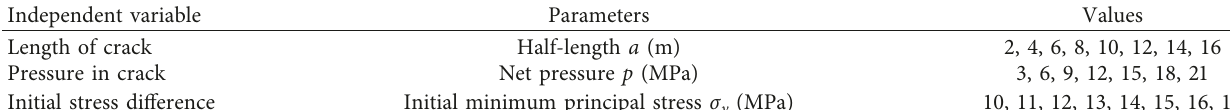
Table 2: Parameter analysis of the calculation parameters of each scheme.